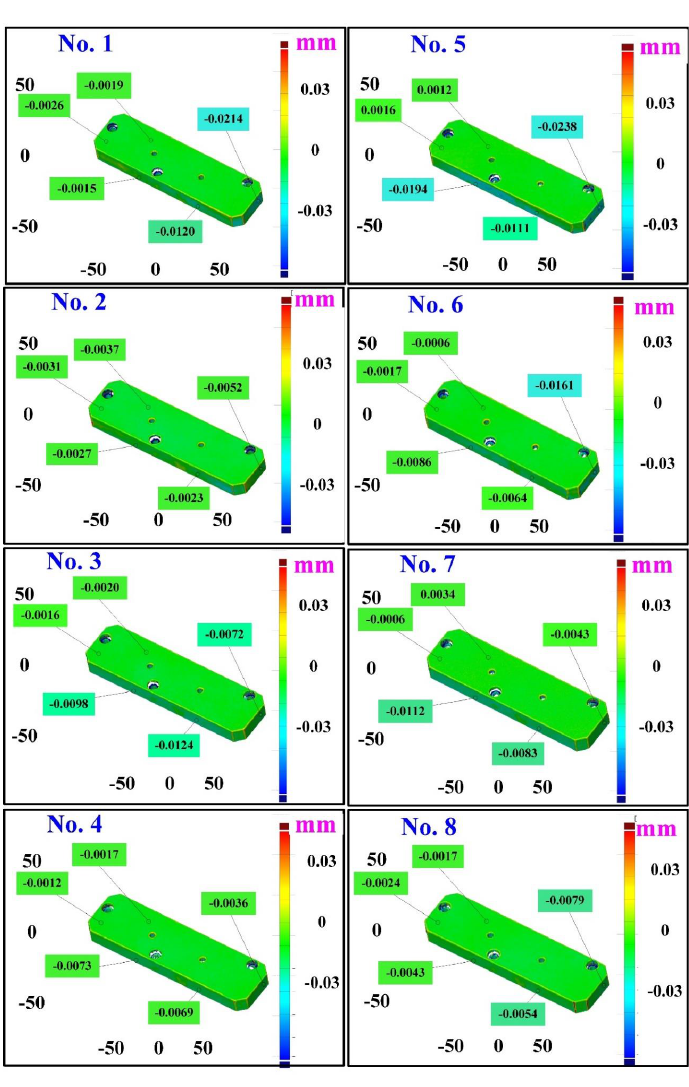
Figure 10. CAV results of the cast part after CNC machining.